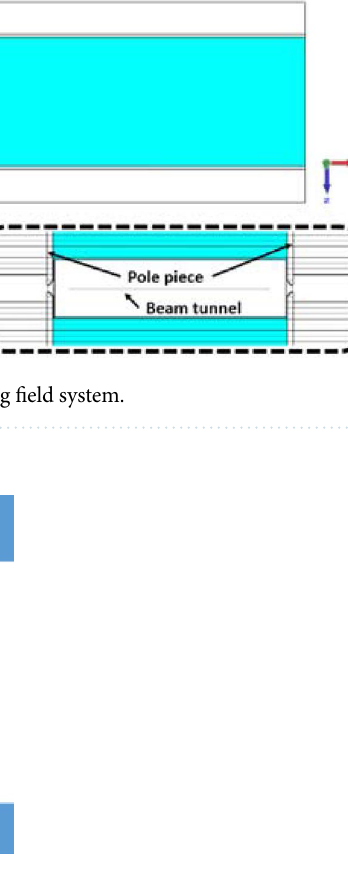
Figure 13. The structure of the pole piece with the stepped